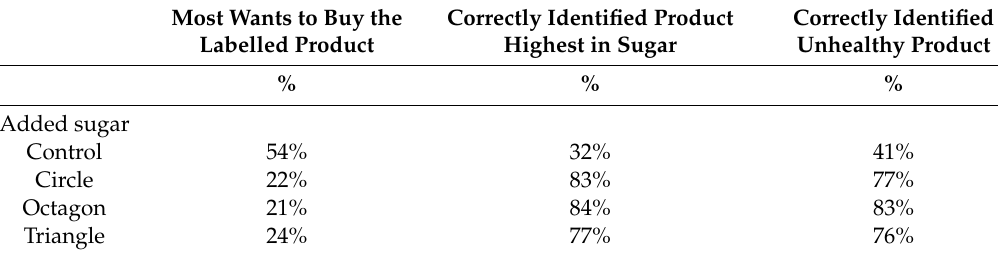
Table A3. Unadjusted proportions. By label type, for fruit drink comparison task. Most Wants to Buy the